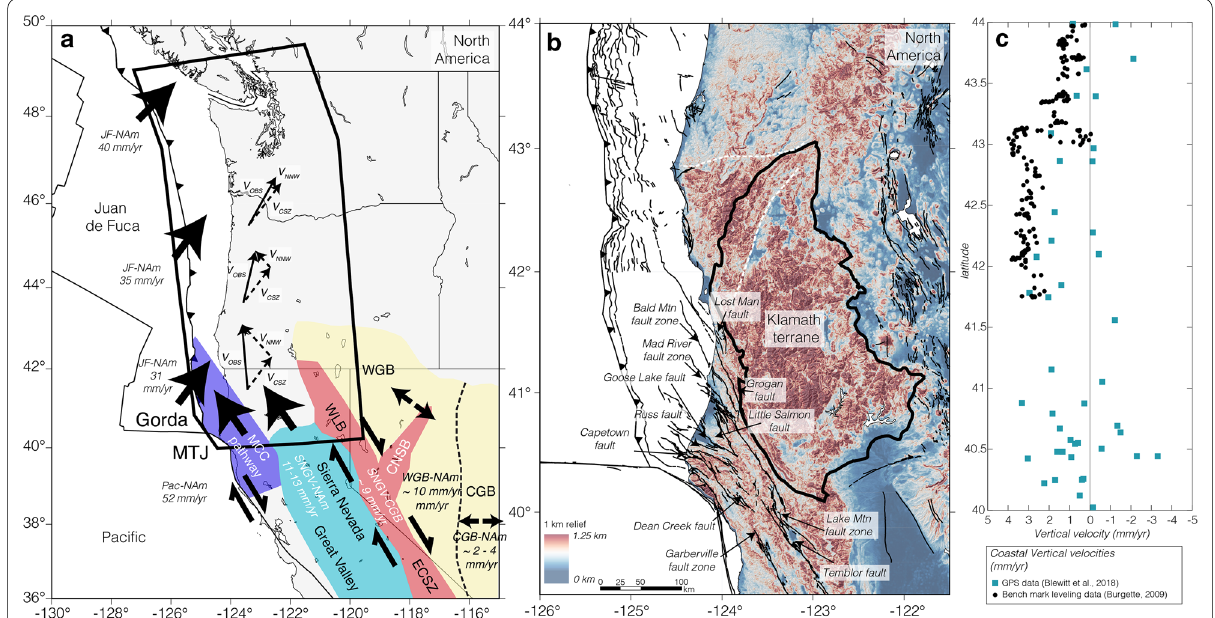
Fig. 1 Maps outlining the active tectonic processes, faults and geologic terranes in Cascadia. a Map of the tectonic processes and their respective kinematics acting across Cascadia. Schematic vector triangles show how the velocity fields produced by subduction coupling (V CSZ ) and NNW-directed processes (specifically the MCC and SNGV-block motion (V NNW )) are superimposed in the Cascadia GPS velocity field (V OBS ). The black polygon outlines the focus region of this study. b Map of active faults within the upper-plate in southern Cascadia (USGS 2020). White dashed lines outline upper-plate faults (Wells et al. 2017; Kirby et al. 2020) that bound an area of high relief from ~ 42° N to ~ 43° N. The upper-plate topographic relief (calculated over a radius of 1 km) is shown in the background (calculated from the 30 m resolution SRTM digital elevation model (Farr et al. 2007)). The Klamath terrane is outlined in black. c Plot of present-day uplift rates from GPS data (from 124.8° W to 123.6° W) (Blewitt et al. 2018) and bench mark leveling data (Burgette et al. 2009) in southern Cascadia. WLB: Walker Lane Belt, ECSZ: Eastern California Shear Zone, CNSB: